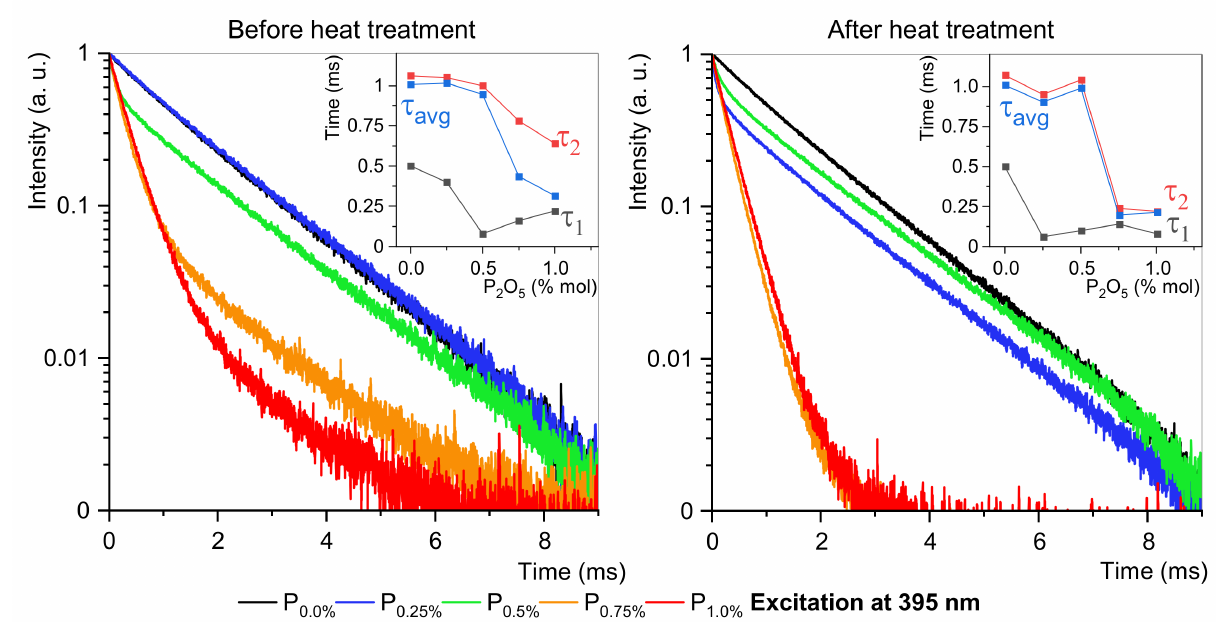
Figure 6. Luminescence decays and τ changes at 395 nm excitation. Lifetimes are in insets.